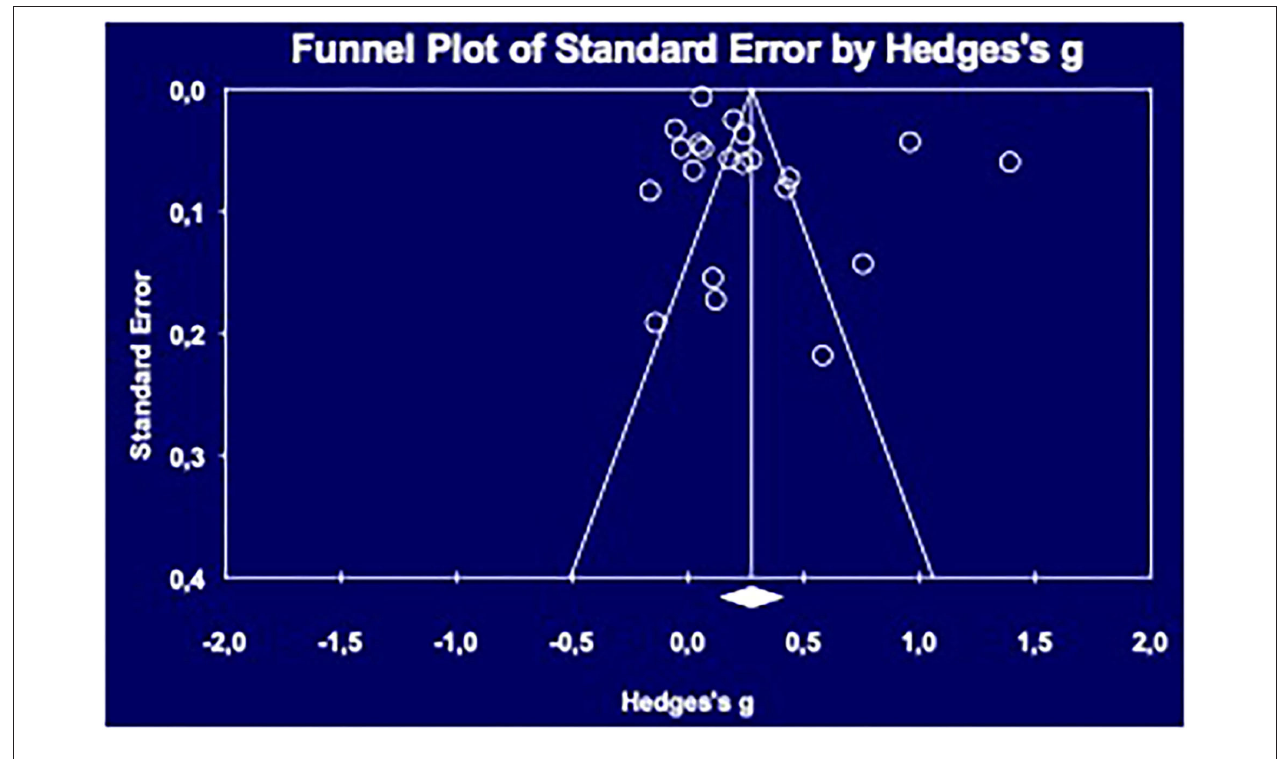
FIGURE 2 | Funnel Plot for publication